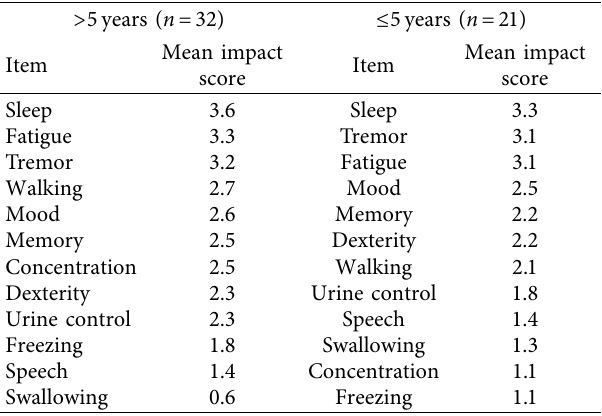
Table 3: Items ranked from highest to lowest mean impact score for the whole sample, as well as by sex and years since PD